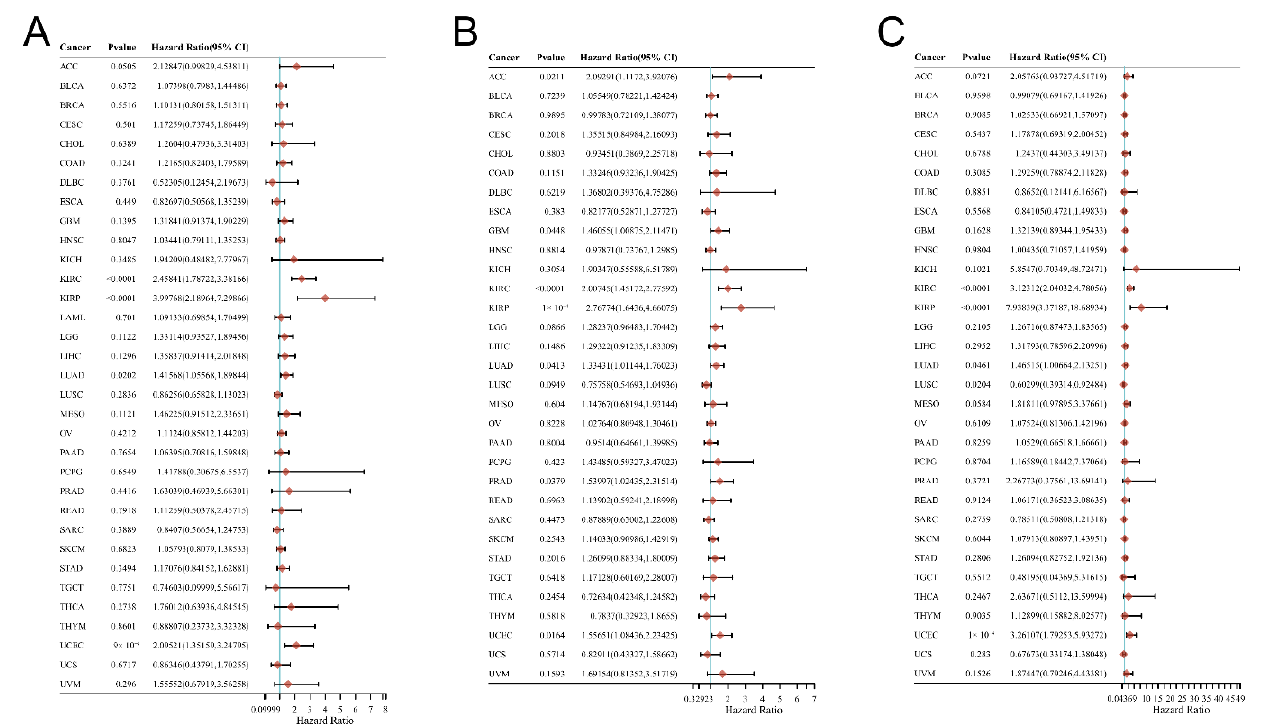
Figure 2. Correlation of the DMRT3 expression in pan-cancerous tumors with prognosis (forest plot). ( A ) OS, ( B ) PFS, and ( C ) DSS. Results of a single-factor Cox analysis of the individual genes in multiple tumors, including the p value, risk factor, HR, and confidence